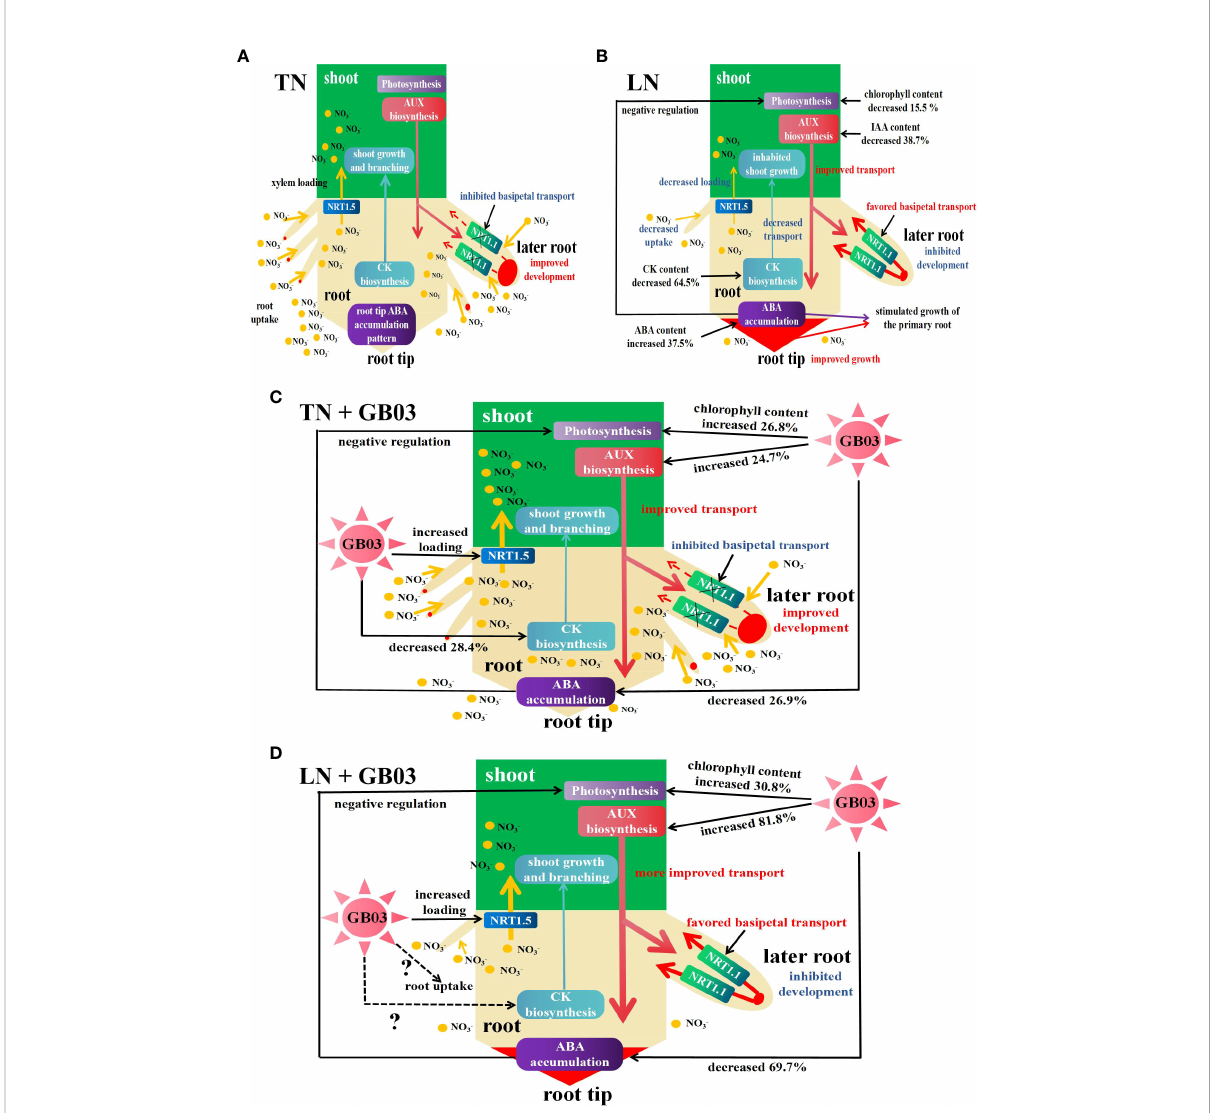
FIGURE 5 Schematic model for the interaction between nitrogen and phytohormones (auxin AUX, cytokinin CK, and abscisic acid ABA) in the regulation of tall fescue growth under different NO 3- treatments with or without GB03. (A) Under TN conditions, AUX was synthesized in the shoot and then was basipetally transported into the root, the NRT1.1 basipetal transport of AUX in lateral roots was inhibited, and AUX was accumulated in the later root tip, triggering the growth and development of later root and uptake of NO 3 - ; CK was synthesized in the root and then was apically transported into the shoot, along with NO 3- loading by NRT1,5 from root to shoot, contributing to the shoot growth and branching; and NO 3- regulated the primary root growth via regulation of ABA accumulation in the root tip. (B) Under LN conditions, AUX translocated from shoot to root was stimulated by a decrease in NO 3- supply, along with NRT1.1 favoring basipetal transport of AUX in lateral roots, enhancing the accumulation of AUX in the primary root tip, which promoted the growth of the primary root versus inhibited the growth and development of the lateral root and impaired NO 3- uptake; the root biomass was decreased; CK biosynthesis and apical transport, as well as NO 3- loading by NRT1,5, were weakened by a decrease in NO 3- supply, and the shoot growth was inhibited; and root tip ABA accumulation was augmented to simulate growth of the primary root and impaired photosynthesis in shoot. (C) Under TN conditions, GB03 enhanced the AUX biosynthesis and basipetal transport in the shoot, and the NRT1.1 basipetal transport of AUX in lateral roots was inhibited, and AUX was accumulated in the later root tip, increasing the growth and development of later root and uptake of NO 3- ; CK content was decreased by GB03 which might contribute to stimulate NO 3- uptake by root, because of CK which had a negative regulation of nitrogen uptake-related genes; and the root tip ABA accumulation was decreased by GB03, which hindered the primary growth regulated by ABA. The abovementioned contributed to the increase in root biomass. Meanwhile, the reduction of ABA caused by GB03 negatively regulated photosynthesis, and GB03 enhanced chlorophyll content and NO 3- loading in the xylem, and the shoot growth was promoted. (D) Under LN conditions, the dual function of GB03 increased AUX biosynthesis and LN stimulated AUX basipetal transport in the shoot, leading to more AUX being accumulated in the root. However, the strong decrease in ABA accumulation caused by GB03 blocked the growth of primary root; this effect was greater than AUX accumulation which was induced by NRT1.1 basipetal transport in lateral roots. Finally, GB03 effectively alleviated primary root elongation at a low nitrogen level. Meanwhile, GB03 preferentially augmented shoot growth by improving photosynthesis and shoot total nitrogen content to resist low nitrogen